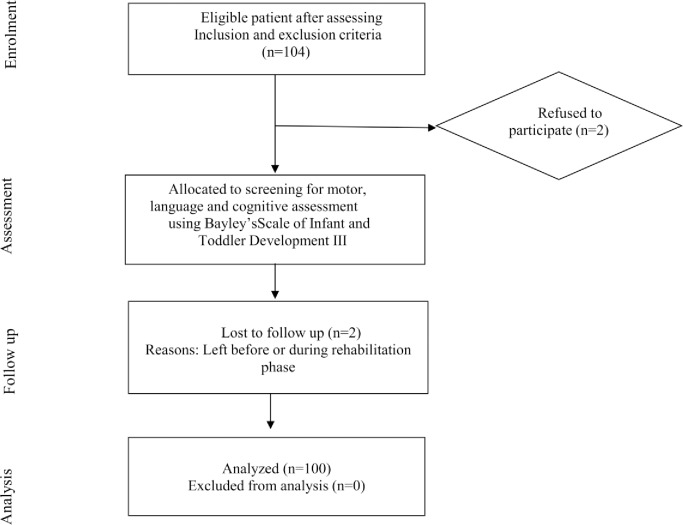
Flow chart of children recruited in the study.